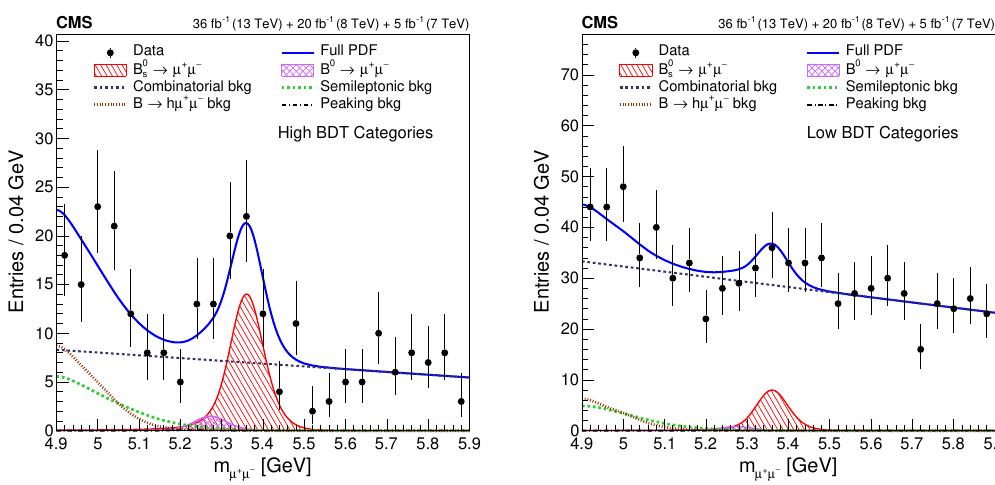
Figure 5 . Invariant mass distributions with the (cid:12)t projection overlays for the branching fraction results. The left (right) plot shows the combined results from the high- (low-)range analysis BDT categories de(cid:12)ned in table 1. The total (cid:12)t is shown by the solid line and the di(cid:11)erent background components by the broken lines. The signal components are shown by the hatched distributions.